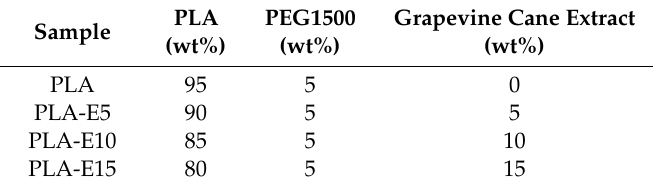
Table 1. Formulation of the polylactic acid (PLA) based